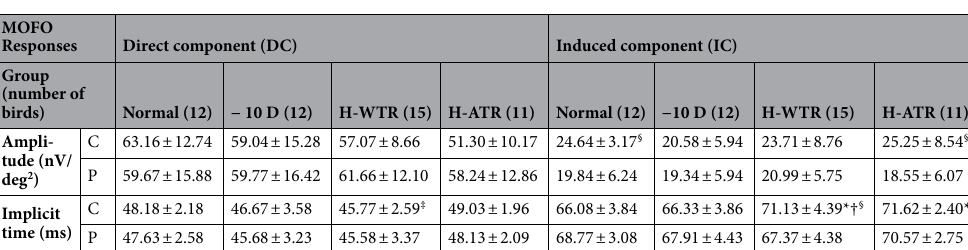
Table 2. Effects of visual manipulations on the amplitude and implicit time of MOFO responses. Comparisons of amplitude and implicit time of the direct (DC) and induced (IC) components across the four groups of birds. Note that the amplitudes of direct component (DC) and induced component (IC) were calculated from peak-to-peak, whereas the implicit times of DC and IC responses were calculated from the onset of multifocal flash and global flash, respectively, as illustrated in the Fig. 4d. A mixed-modal ANOVA was used to compare the differences in MOFO responses (amplitude and implicit time) between groups (Normal, − 10 D, H-WTR and H-ATR groups) and within groups (central [C] vs peripheral [P]). The level of significance is indicated as follows: *p < 0.05, comparisons between groups (normal vs three treatment groups); † p < 0.05, comparisons between – 10 D and two sphero-cylindrical lenses treated groups; ‡ p < 0.05, comparisons between two sphero- cylindrical lenses treated groups (H-WTR and H-ATR) and § p < 0.05, comparisons within groups (central vs peripheral) between